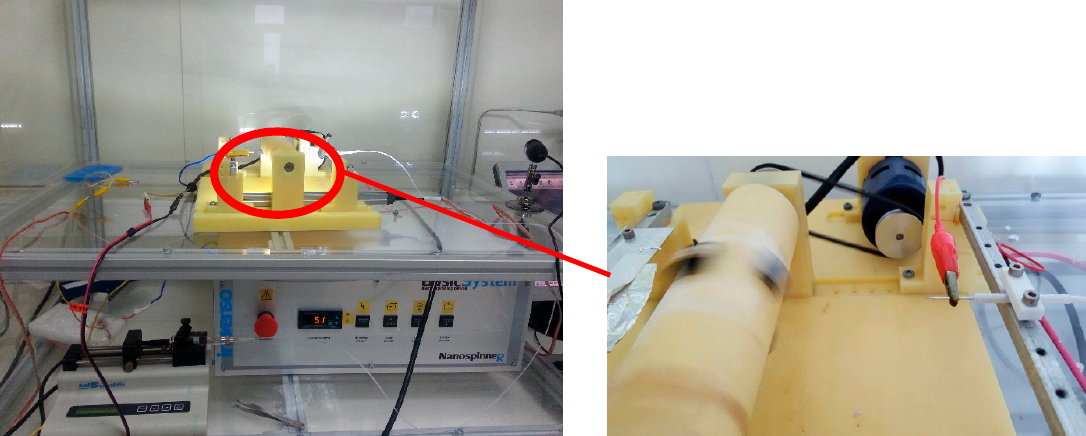
Figure 1. Photograph of the electrospraying system.